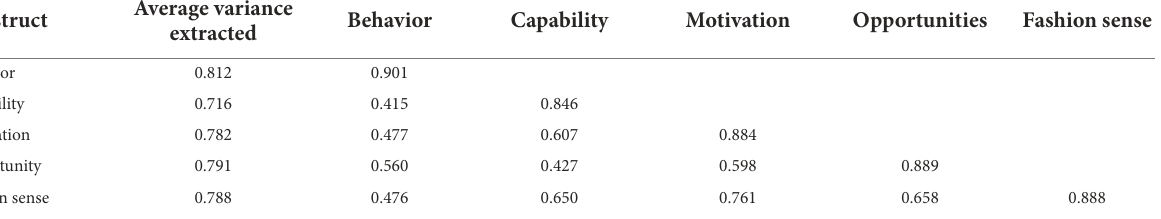
TABLE 4 Discriminant validity.